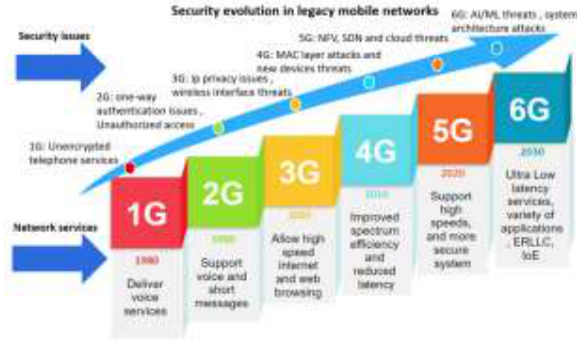
Figure 5. © The security evolution of mobile communications from 1G to the predicted future 6G Copyright 2022,